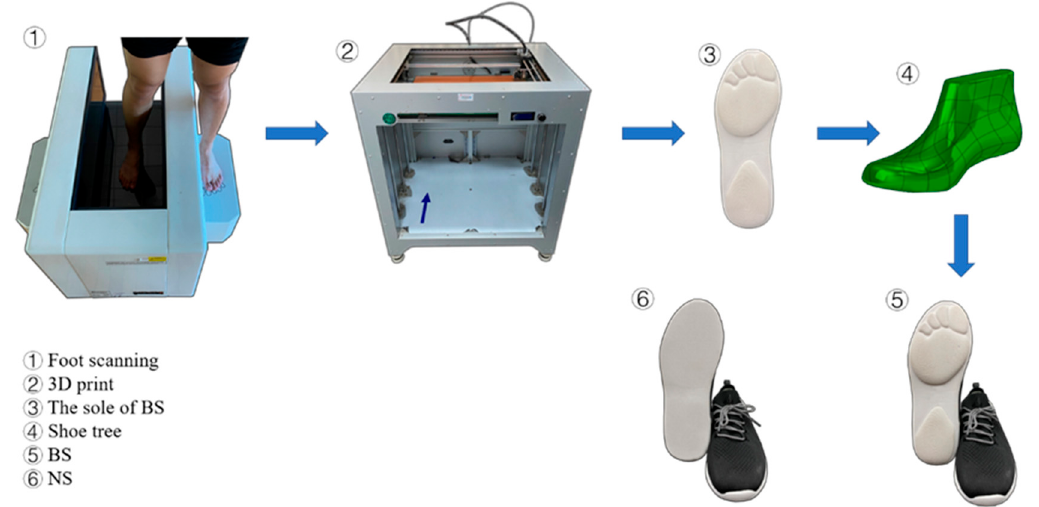
Figure 1. Illustration of shoe-making procedure from initial idea to finished product. Int. J. Environ. Res. Public Health 2021 , 18 , x